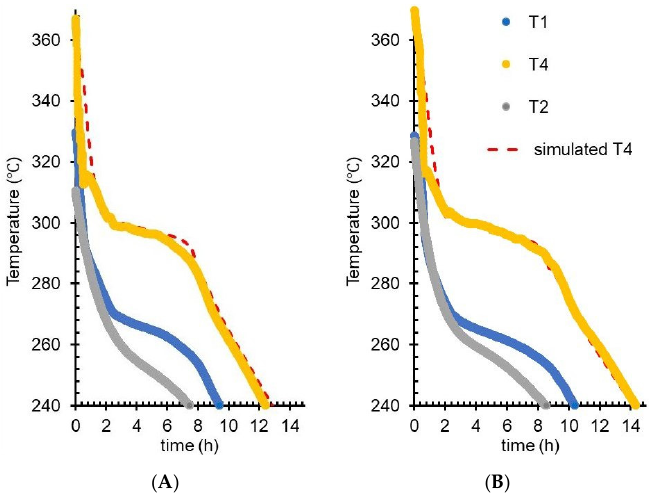
Figure 9. FEM simulations of T4 (red segmented line) in the self-discharge experiment, compared with experimental data (filled circles) for T1 (blue), T2 (gray), and T4 (yellow): ( A ) 19.23 kg microcapsules load and ( B ): 22.07 kg load.